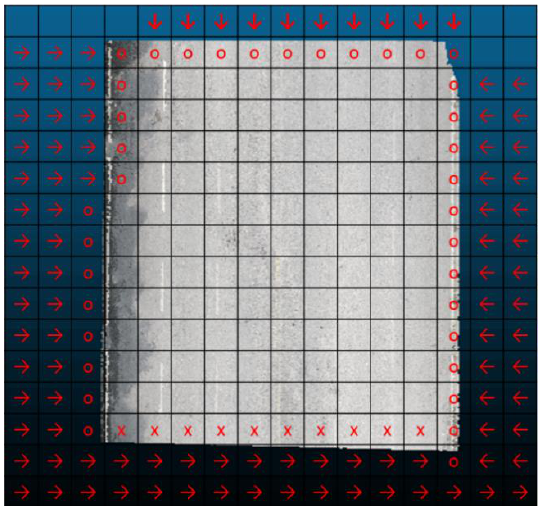
Figure 9. Schematic diagram of searching for border grids. Arrows label the checking directions and all the grids checked, circles mark the border, and crosses represent the interpolated grids for gaps.